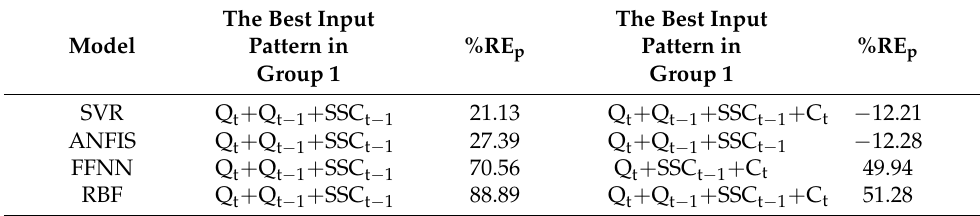
Table 9. Assessment of models based on relative error in peak SSC for the best model using only hydrological variables and the best model using hydrological variables along with C-factor for Boostan Dam